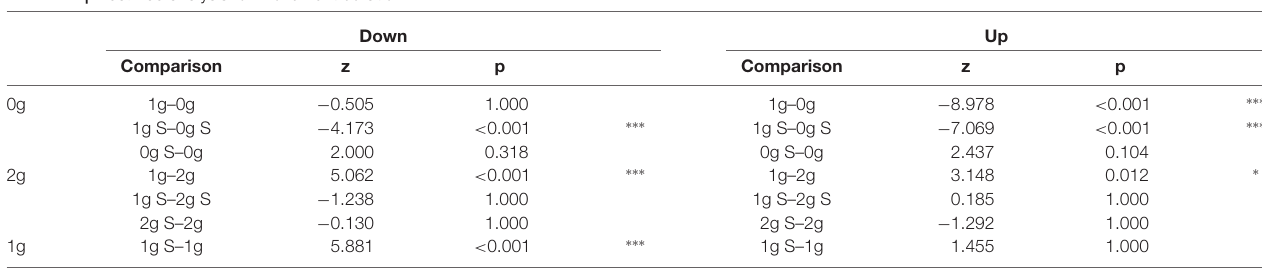
TABLE 2 | Post hoc analysis for movement